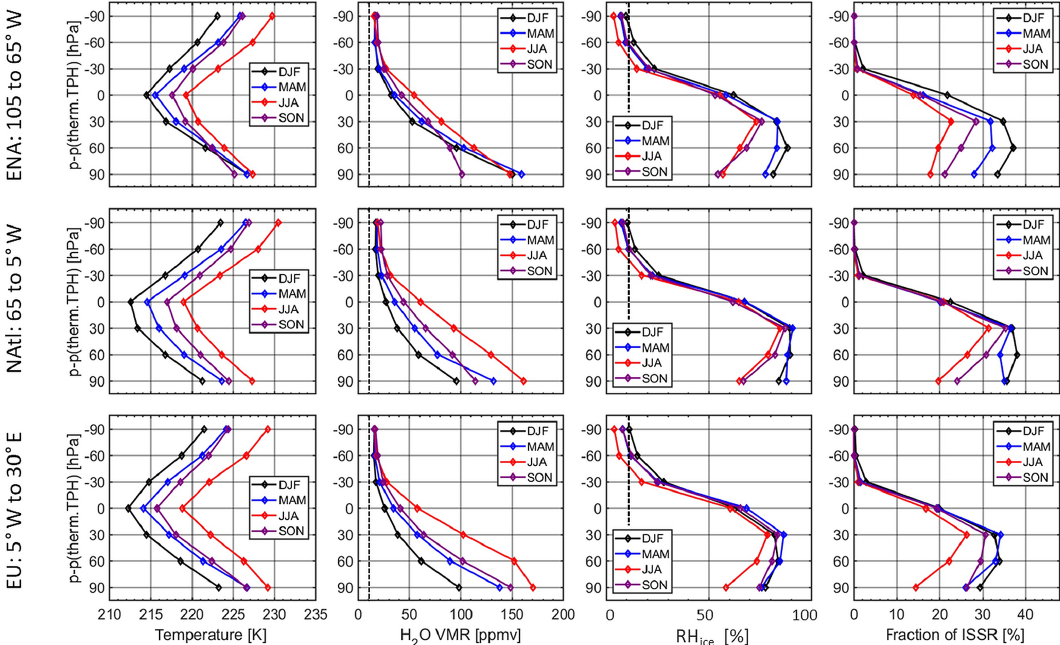
Figure 8. Vertical distribution of mean temperature, H 2 O mixing ratio, RH ice and fraction of ice-supersaturated regions (ISSR) for seven pressure layers around the thermal tropopause. Layer thickness is 30hPa, and layers are spaced equally relative to the tropopause pressure level. Dotted lines indicate the MCH 2 σ limit of detection of RH ice,LOD = 12% and the resulting minimum detectable H 2 O VMR of approx.